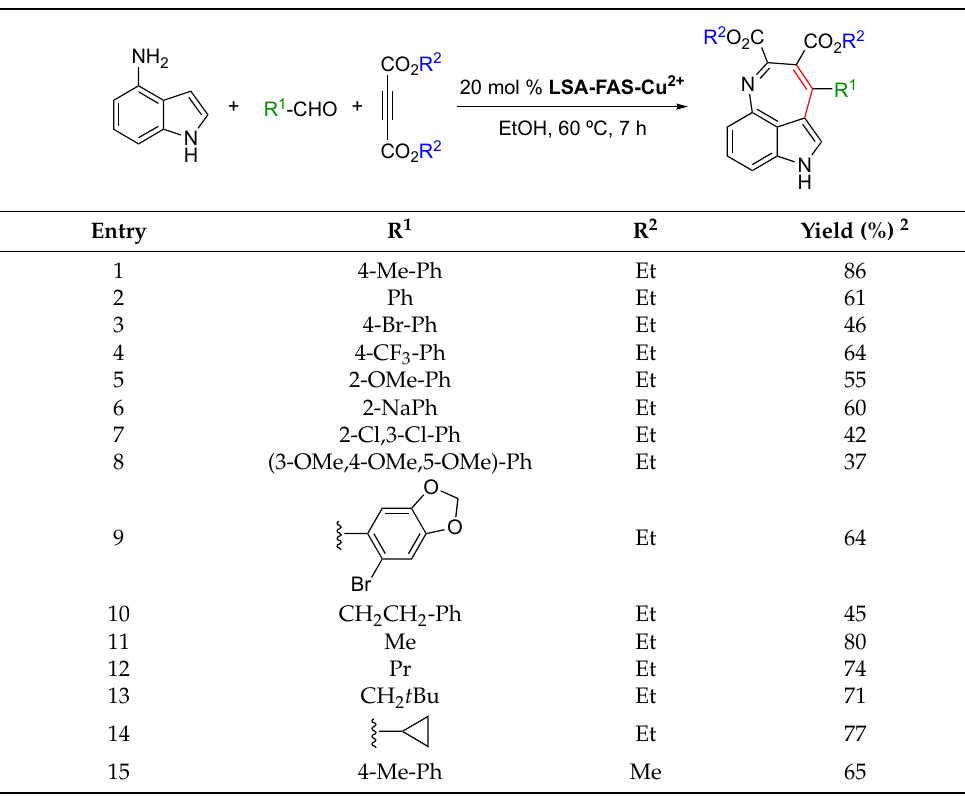
Table 4. LSA-FAS-Cu 2+ catalyzed three-component reactions of 4-aminoindoles, alkynes, and alde- hydes [34] 1 .